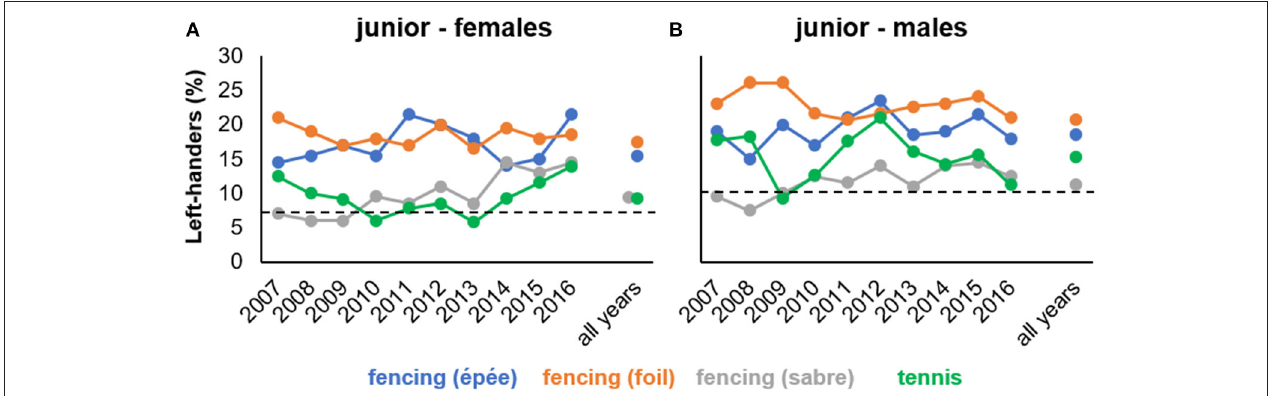
FIGURE 3 | Percentages of left-handed athletes for each year-end ranking and collapsed across all years listed for a particular sport separately for (A) female and (B) male junior competition (study 2). Horizontal dashed lines represent reference values for normal population estimates of left-handedness in females (7.7%) and males (10.3%), respectively (Raymond et al.,